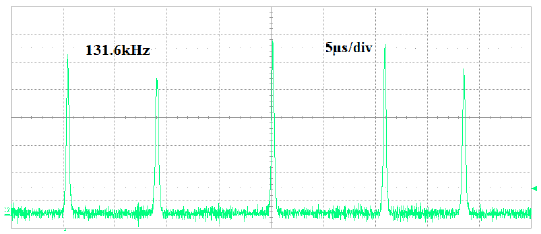
Figure 7. Typical pulse train for 2.2 W output power.